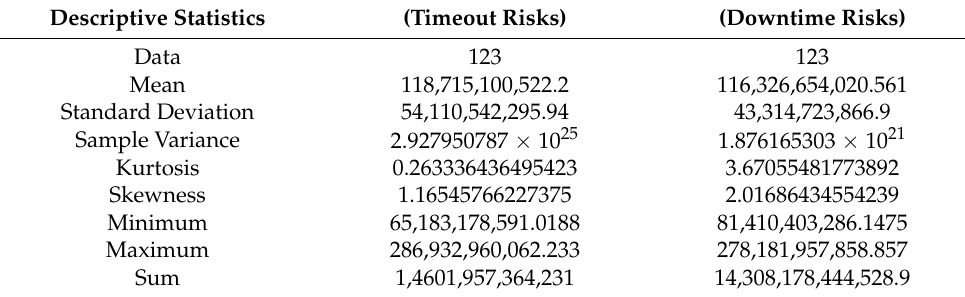
Table 4. Extreme data of the descriptive statistics.